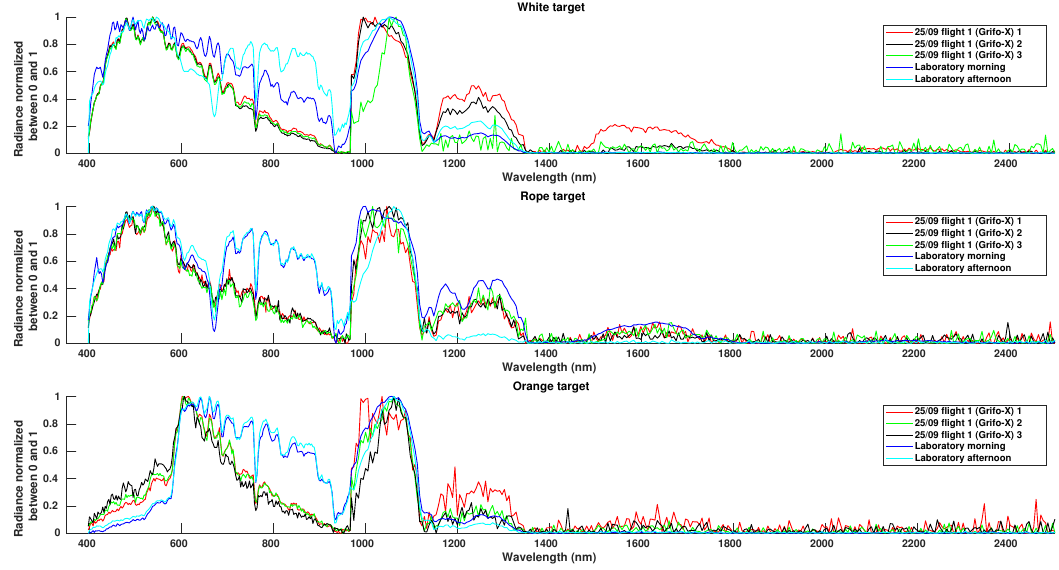
Figure A4. Results for the 25/9 Grifo-X first flight, analyzing 3 different pixels (bright pixel-1, a medium pixel-2 and a dark pixel -3) for each material, and comparing them to the laboratory